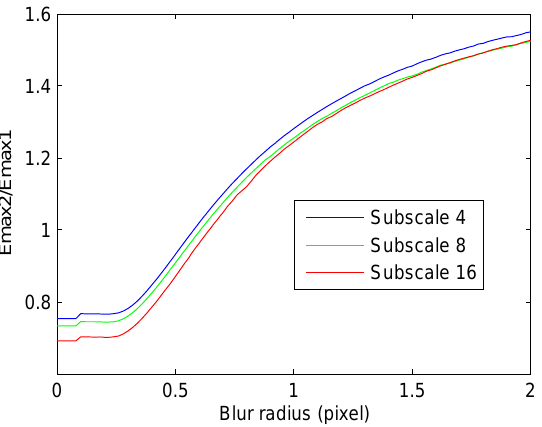
Figure 6: Point spread function at one of the 9 points estimated using a Siemens